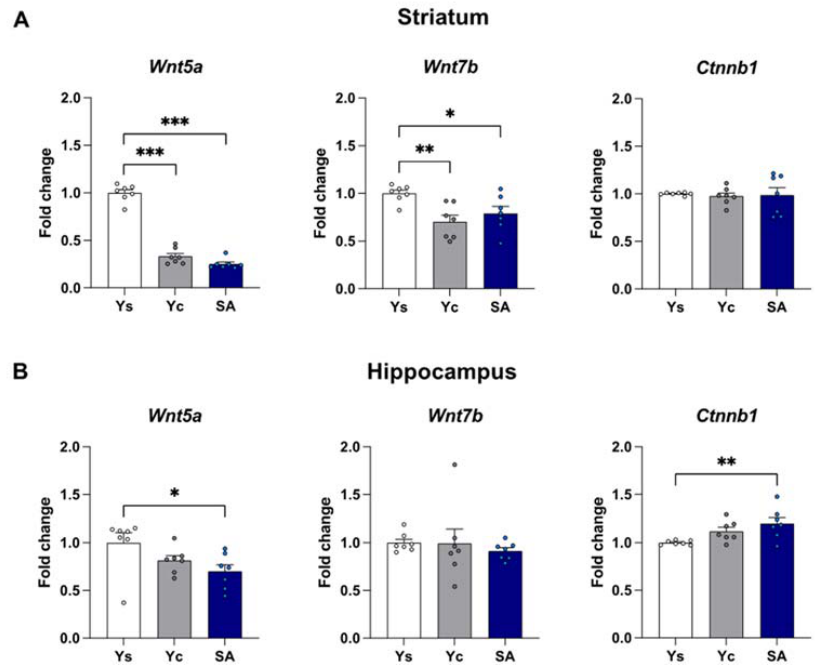
Figure 4. The mRNA expression levels of Wnt5a , Wnt7b , and Ctnnb1 in the striatum ( A ) and hippocampus ( B ) after 3 days of cocaine abstinence in the home cage. n = 7 rats/group. Significance was determined using a one-way ANOVA and the post hoc Dunnett’s test. * p < 0.05, ** p < 0.01, *** p < 0.001 versus the yoked saline (Ys) control group. SA: cocaine self-administration group; Yc: yoked cocaine group.